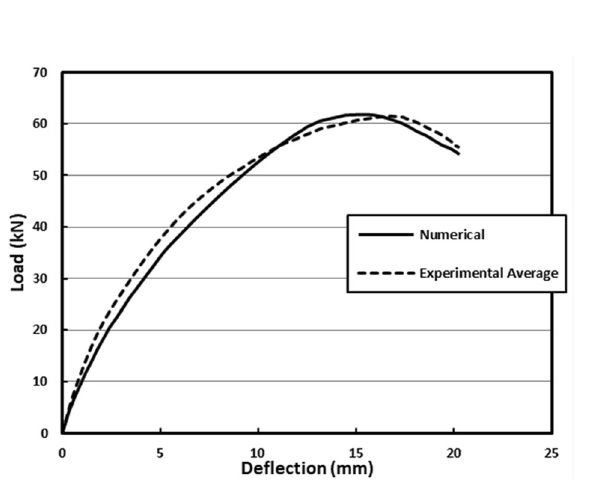
Figure 5. Numerical vs experimental behaviour.